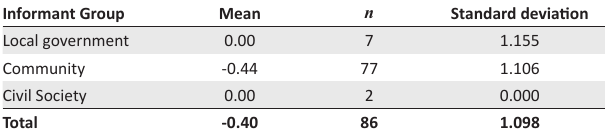
TABLE 14: Changes in disaster loss per informant groups (mean scores).